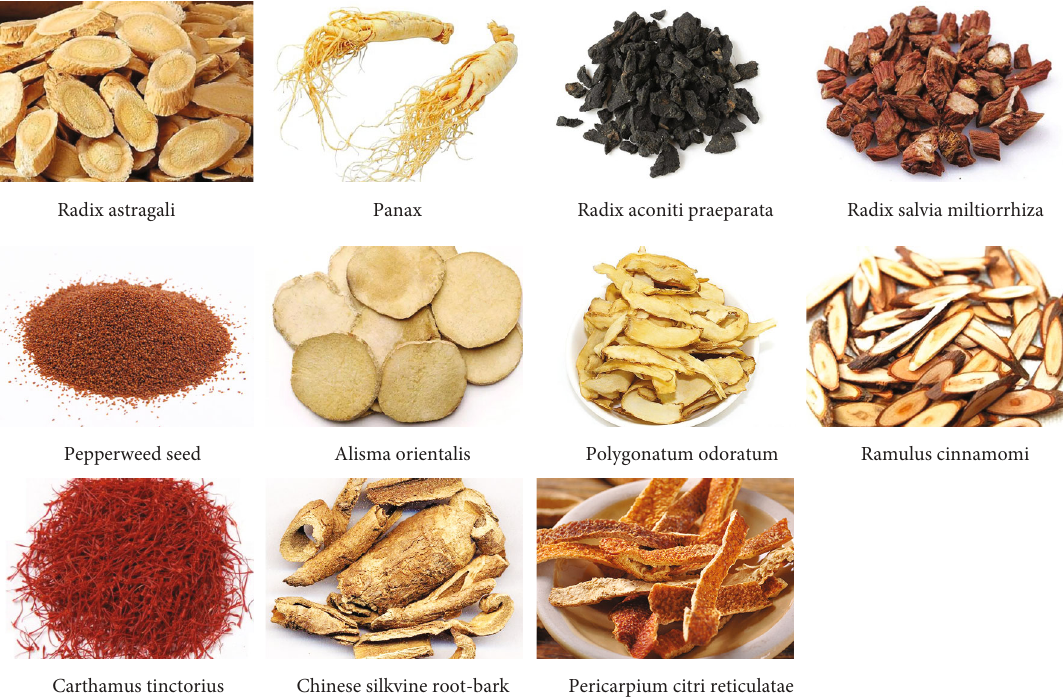
Figure 1: The morphology of 11 raw herbs that compose traditional Chinese medicine Qiliqiangxin